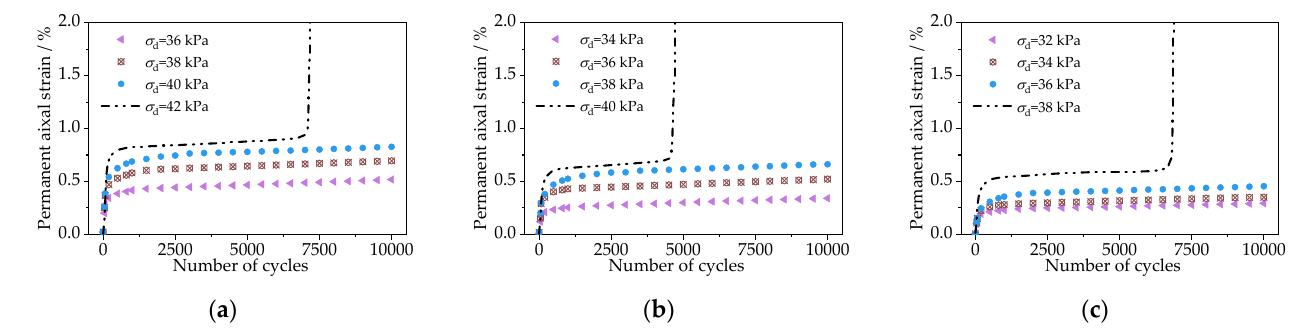
Figure 10. Permanent axial strain under unloading and reloading stress path. ( a ) CU − 1 (unloading intensity = 10 kPa); ( b ) CU − 2 (unloading intensity = 20 kPa); ( c ) CU − 3 (unloading intensity = 40 kPa).